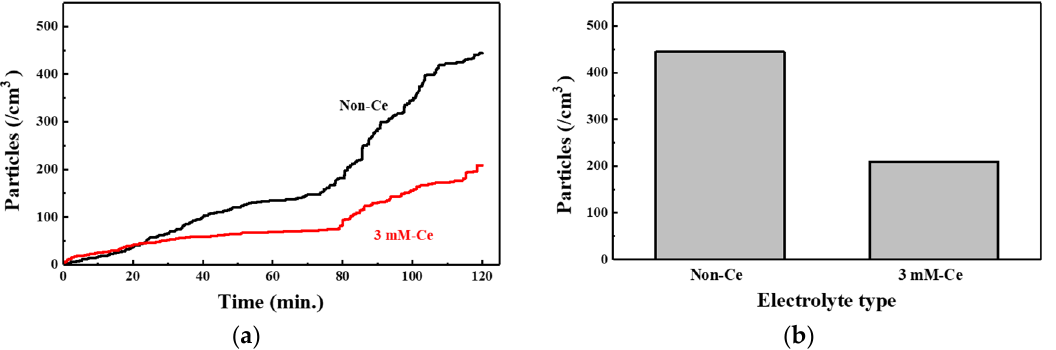
Figure 8. Breakdown voltage of AAO film with change in Ce ion addition: ( a ) before plasma treatment, ( b ) after plasma treatment.